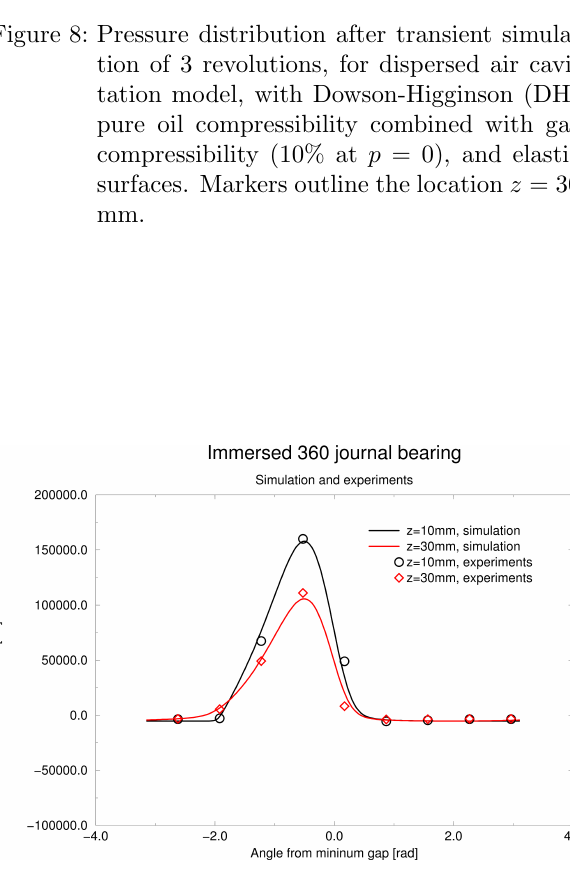
Figure 9: Comparsion between experiments and simu- lation for z = 10 mm and z = 30